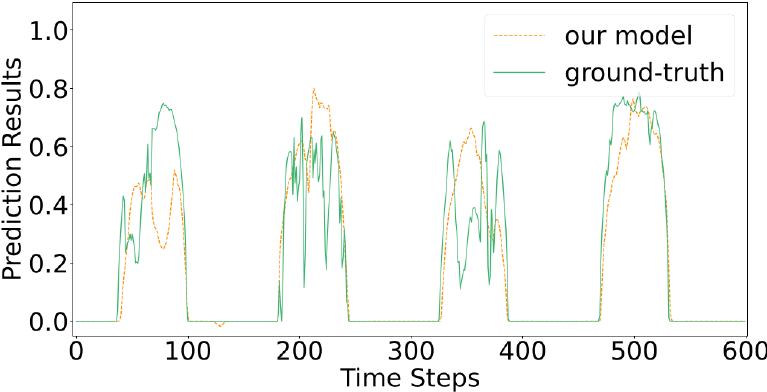
Figure 12. Solar Energy (Horizon = 24) forecast